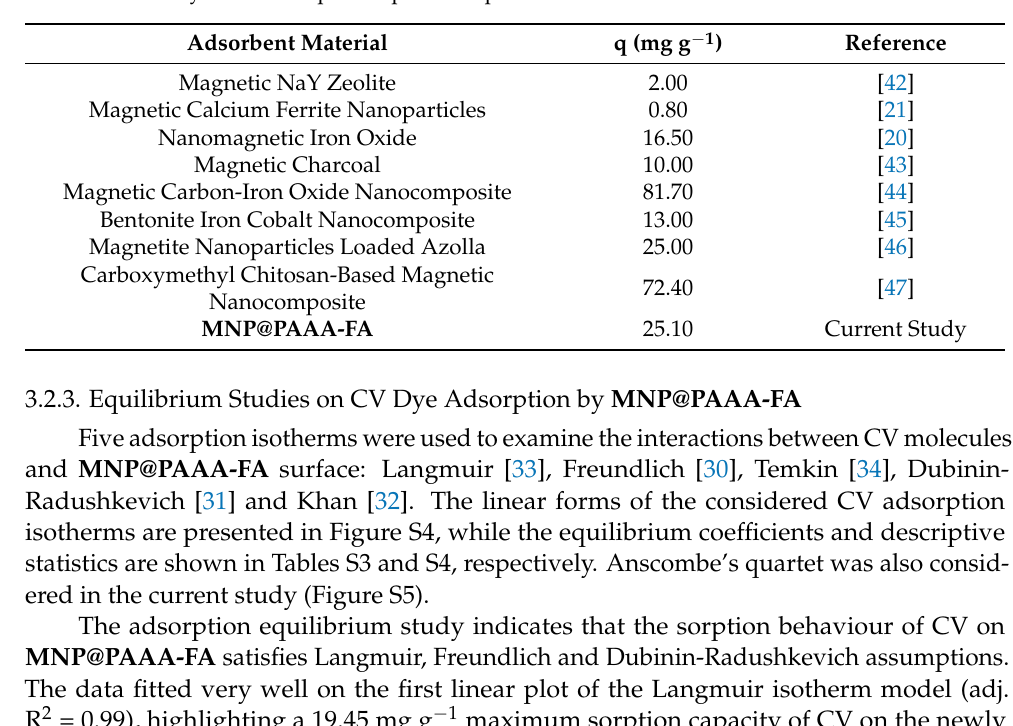
Table 1. Summary of CV adsorption capacities reported in the literature for different adsorbent